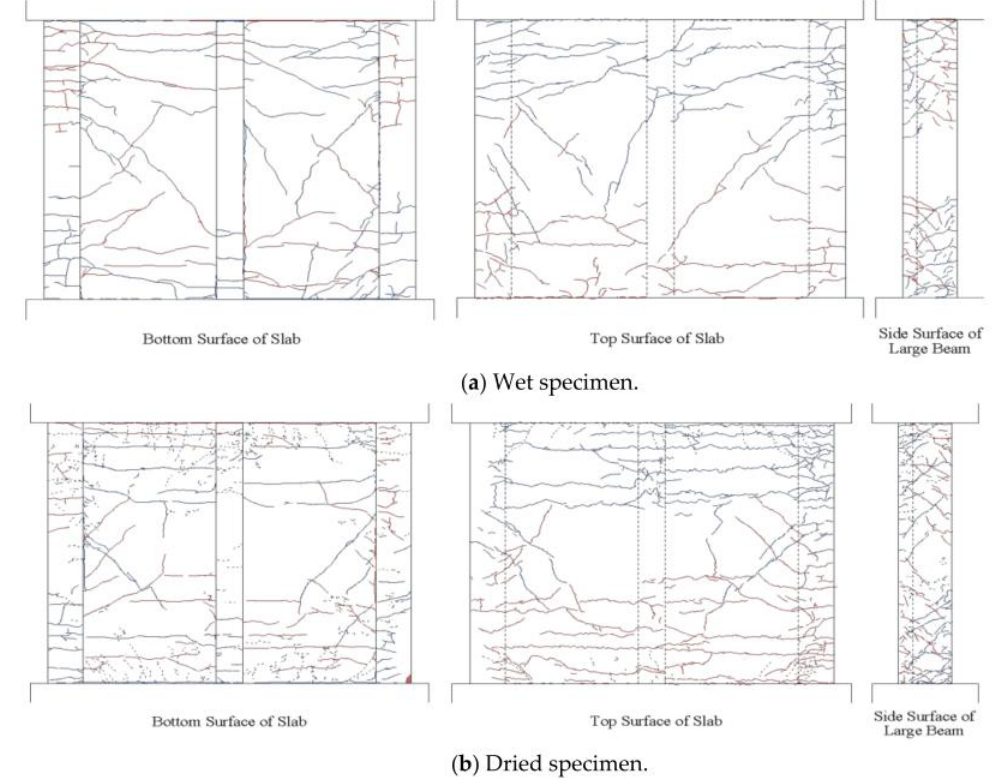
Figure 13. Crack patterns. ( a ) Wet specimen, ( b ) dried